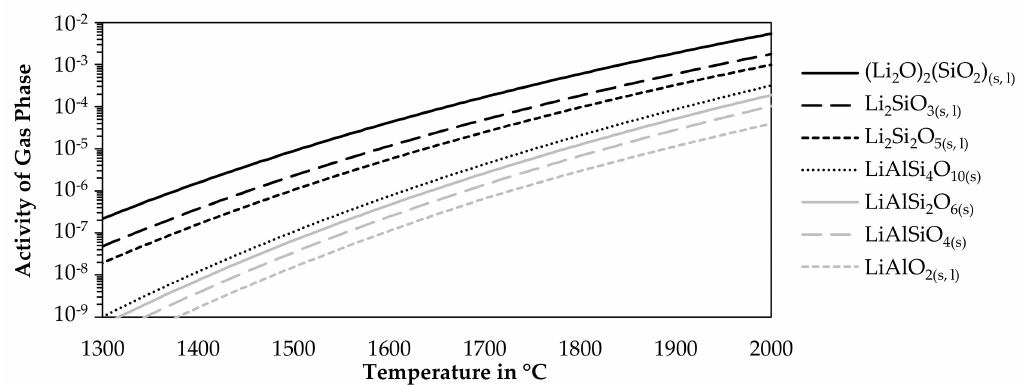
Figure 6. Activity of the gas phase in equilibrium with pure lithium